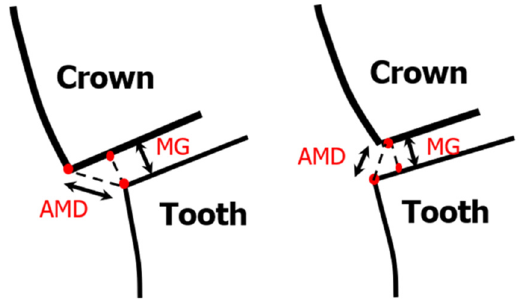
Figure 4. Schematic diagram showing MG and AMD measurement scheme at the crown-abutment junction for positive and negative overhang.